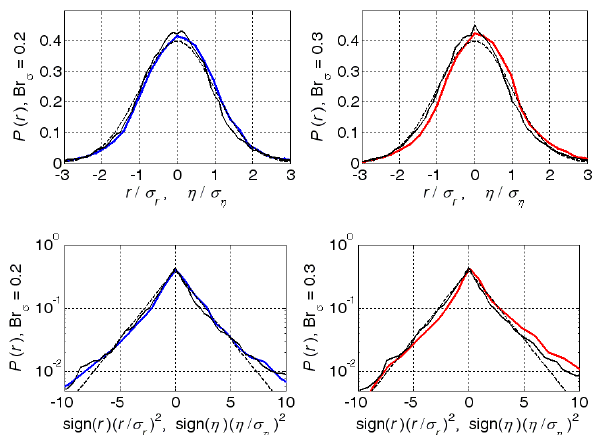
Fig. 7. Probability density functions of wave runup and the incident wave elevation in linear (top) and semi-logarithmic (bottom) scale. Colour lines correspond to runup statistics and black lines show distribution of the water elevation in the incident wave which is separately plotted in Fig. 5. Black dashed lines show the Normal